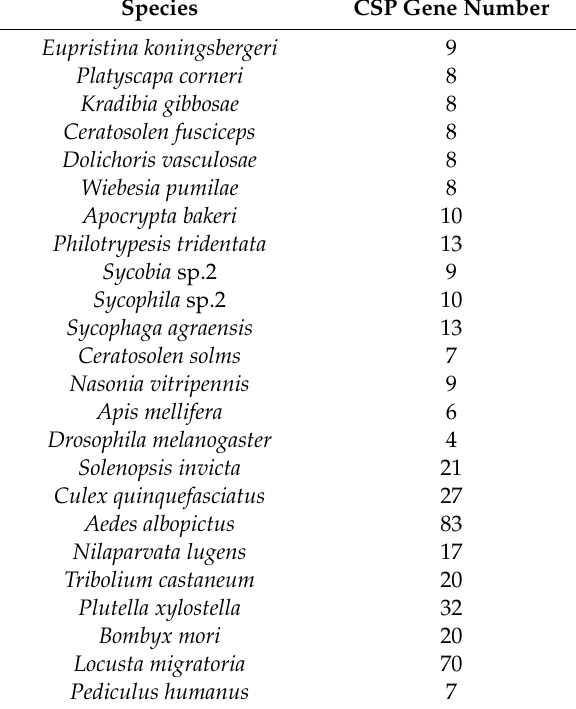
Table 1. The number of chemosensory proteins (CSP) genes in di ff erent insect species. Species CSP Gene